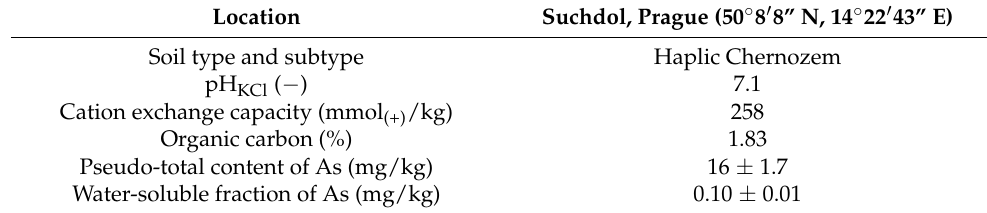
Table 3. Characteristics of experimental